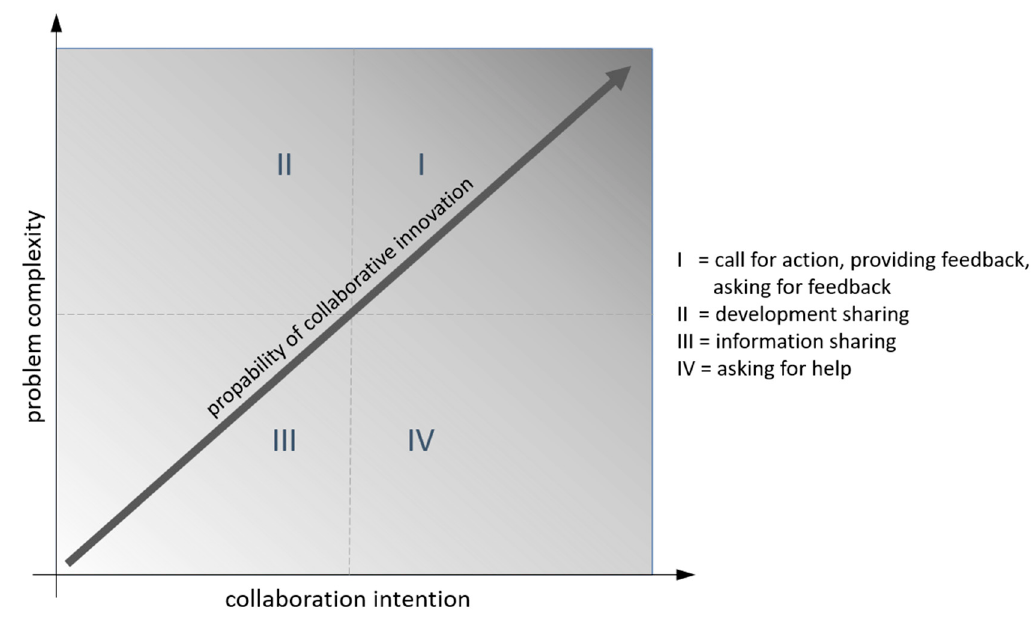
Figure 2. Impact of factors inherent to the initial post of a thread on the probability of collaborative